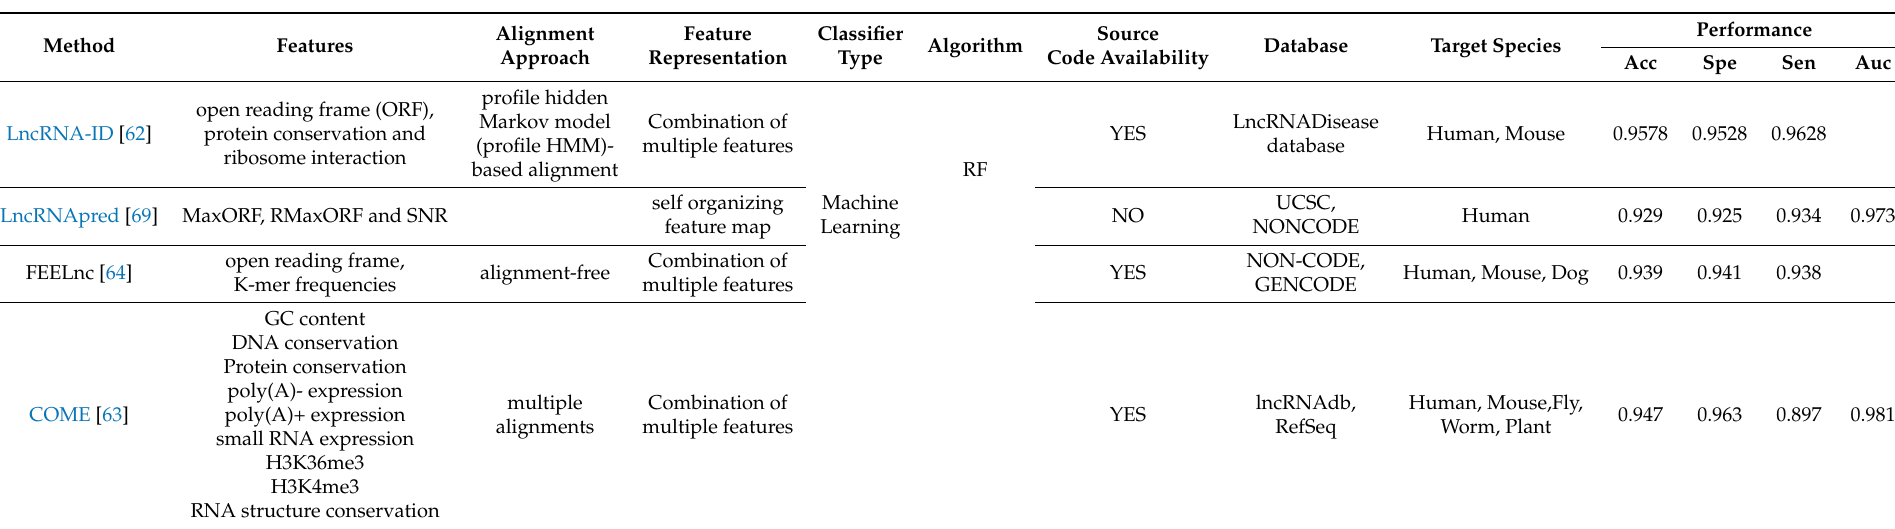
Table 2. A Broad Classification of Approaches Proposed to Distinguish LncRNAs from Protein-Coding